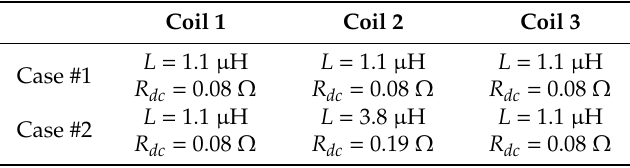
Figure 5 . Experimental setup for measuring the coupling coefficient of three coils. Table 1. Parameters of coils used in measurement.